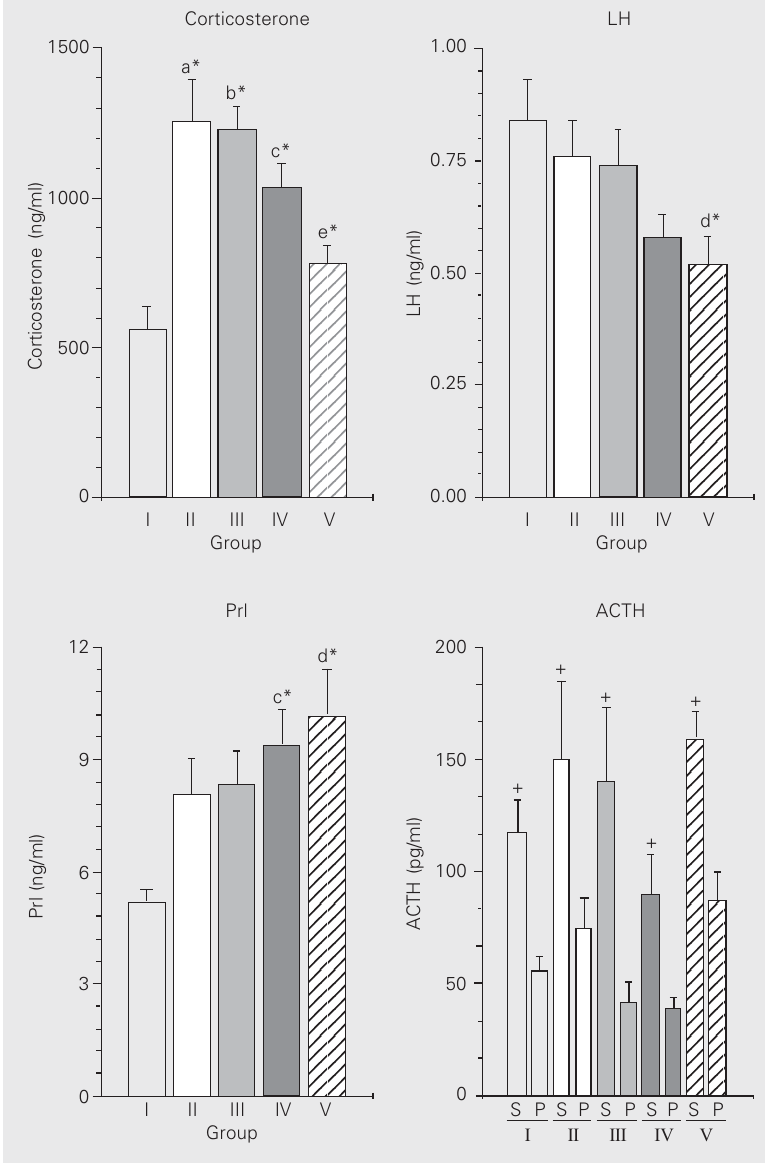
Figure 2. Plasma hormone levels: prolactin (Prl), luteinizing hormone (LH), corticosterone (CT), and adrenocorticotropic hormone (ACTH) in the following groups: I, no manipulation; II, 30 min for adaptation of the animals of the same original group to a new cage; III, 30 min for adaptation of the animal isolated from the group and placed in a new cage; IV, 30 min for adaptation and 15 min for the collective exploratory test; V, 30 min for adaptation and 15 min for the individual exploratory test. For plasma ACTH determination, the groups were divided into two subgroups: “S” (the most stressed animal in the cage) and “P” (the other two partners). *P < 0.05, significant differences were observed between a) group I vs II, b) group I vs III, c) group I vs IV, d) group I vs V, e) group III vs V (one-way ANOVA). + P < 0.05, significant differences were observed between subgroups “S” and “P” within each experimental group for ACTH. The number of animals was 17 for the determination of CT, 17-18 for LH, and 15-17 for Prl. For ACTH, the number of animals was 6/12 for subgroups “S” and “P” in groups I and II, 6/9 for group III, 6/10 for group IV, and 6/11 for group